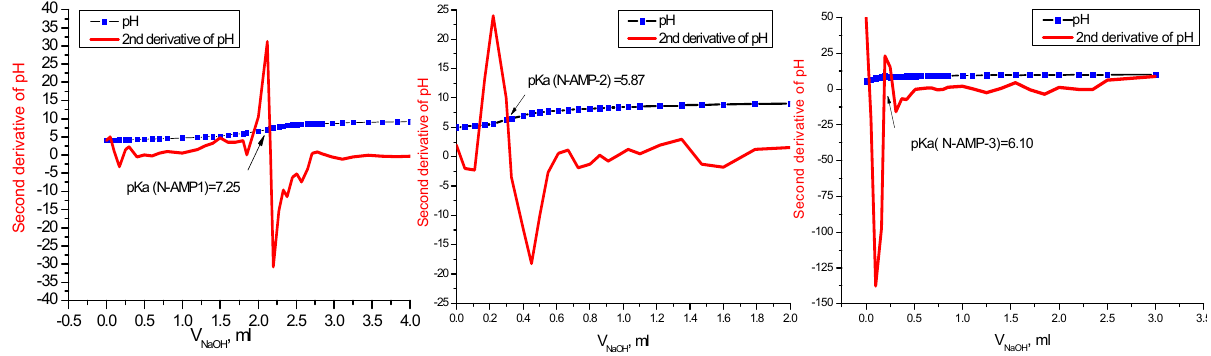
Figure 2. Plot of function (second derivatives of pH) = f(V NaOH , mL) at potentiometric titrations of 16.60 µmol L1, 15.06 µmol L2 and 19.93 µmol L3. Table 1. Values of pKa determination of investigated compounds.